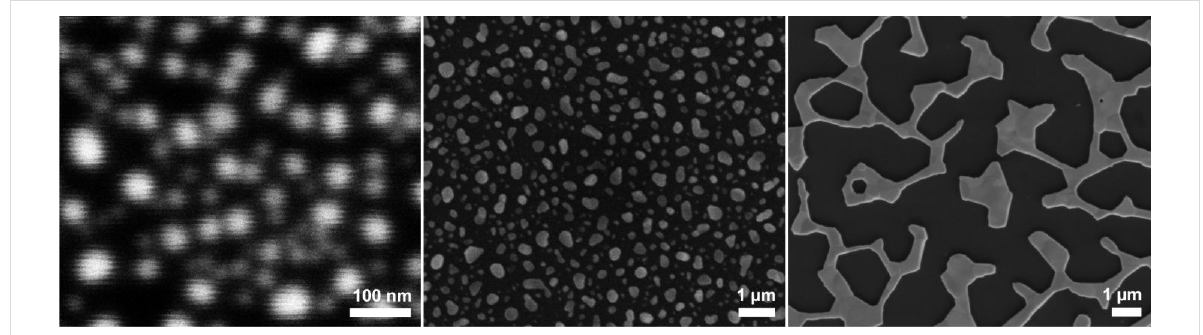
Figure 5: SEM image of gold nanoparticles formed on the native oxide surface of Si[111] after annealing of Au films deposited by sputtering for different lengths of time (left: 30 s; center: 1 min; right: 2 min). The annealing was performed at 650 °C for 1 h.